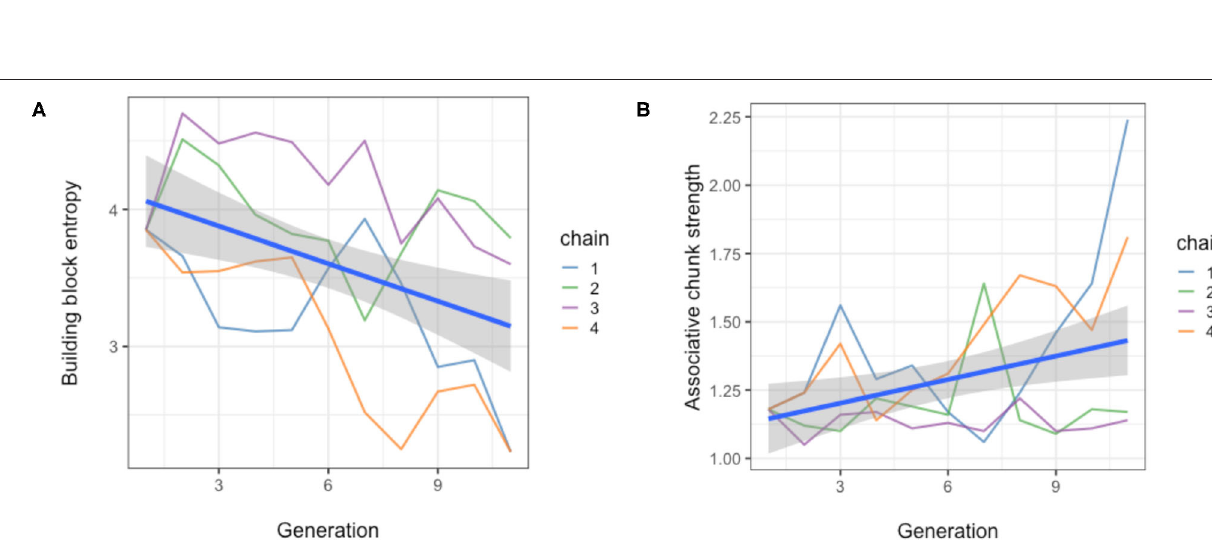
Frontiers in Psychology |